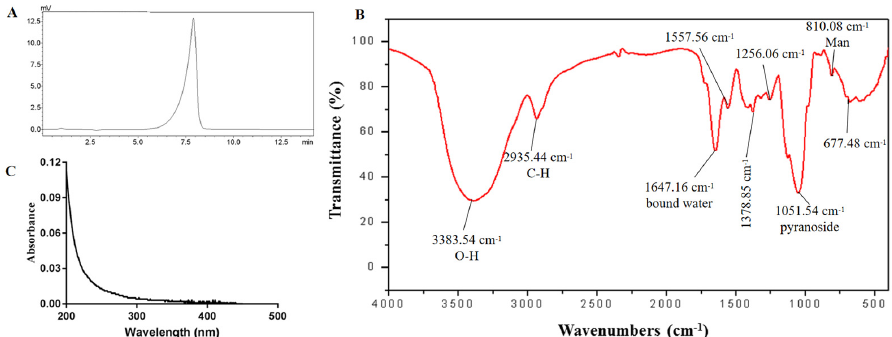
Figure 3. ( A ) HPGPC profile of EPS2 ‐ 1; ( B ) FT − IR spectrum of EPS2 ‐ 1; ( C ) Ultraviolet spectroscopy of EPS2 ‐ 1. Table 1. Monosaccharide composition analysis of EPS2 ‐ 1. Retention Time (min)